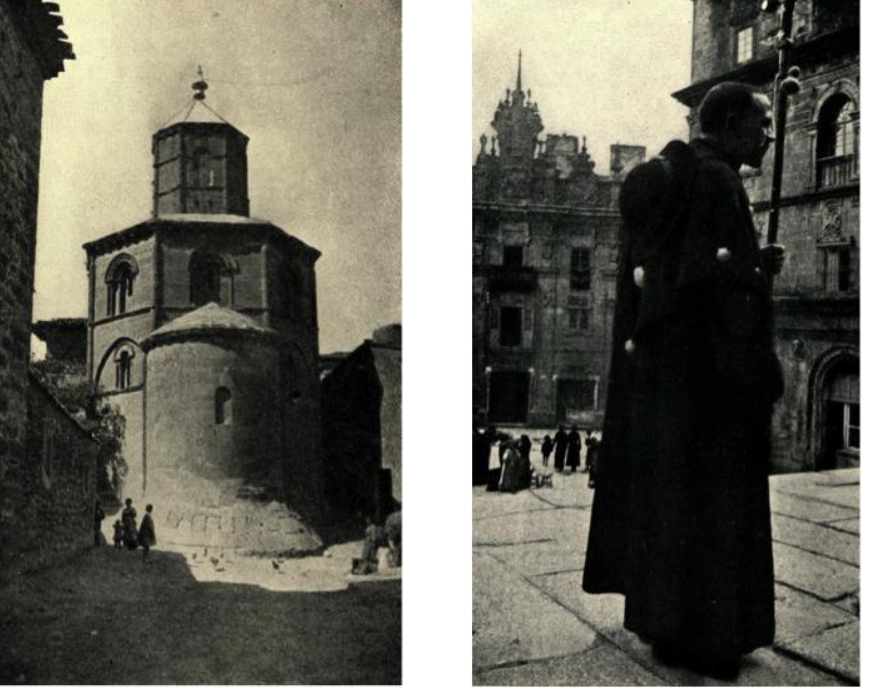
Unidentified photographer, El Sepulcro , from Georgiana Goddard King, The Way of Saint James , vol. 1 (New Y ork: G.P. Putnam’s Sons, 1920), page 311 (photo: author).